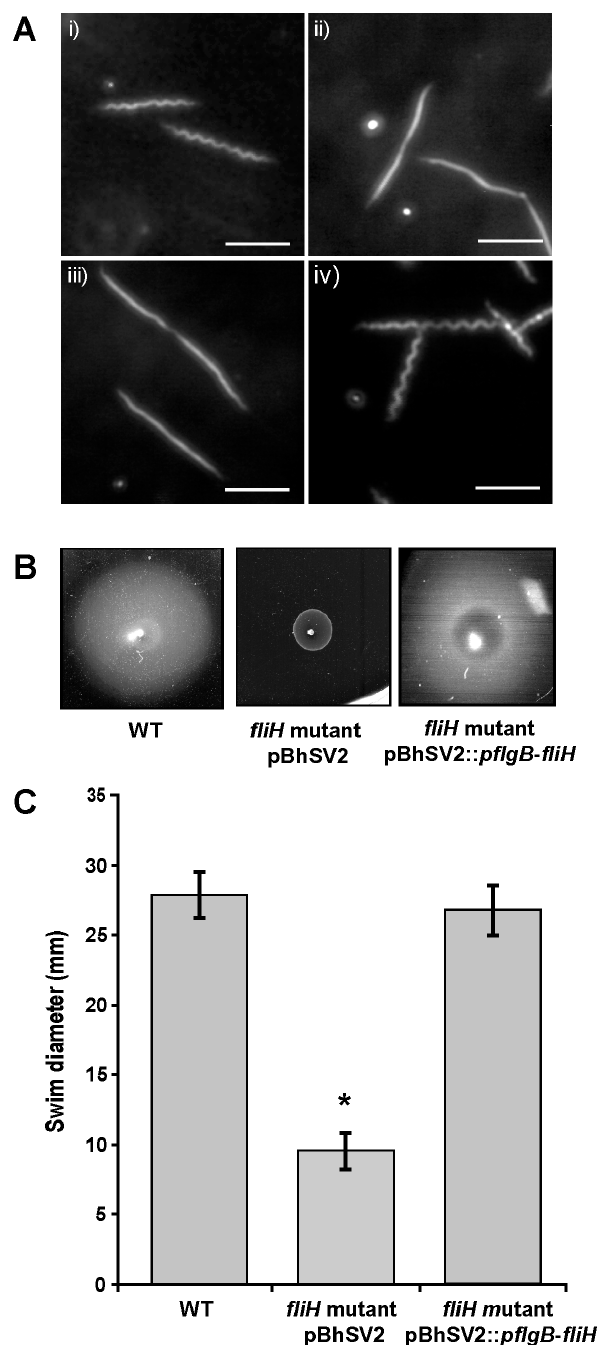
Figure 5. Complementation of the fliH mutant with pBhSV2:: pflgB - fliH restores the wild-type morphology and motility. (A) Darkfield microscopy analysis of B. hermsii wild-type (WT) (i), fliH mutant (ii), fliH mutant transformed with empty vector pBhSV2 (iii) and fliH mutant complemented with pBhSV2:: pflgB - fliH (iv). (B) Representative images of quantitative swimming plate assays show that the wild-type B. hermsii and fliH complemented mutant pBhSV2:: pflgB - fliH swam equally whereas the fliH mutant swam significantly less (B & C). Results are the average of 3 independent biological experiments. The asterisk indicates that the swim diameter of the mutant was significantly less than those of the WT and complemented spirochetes (p , .05). Scale bars represent 10 m m.